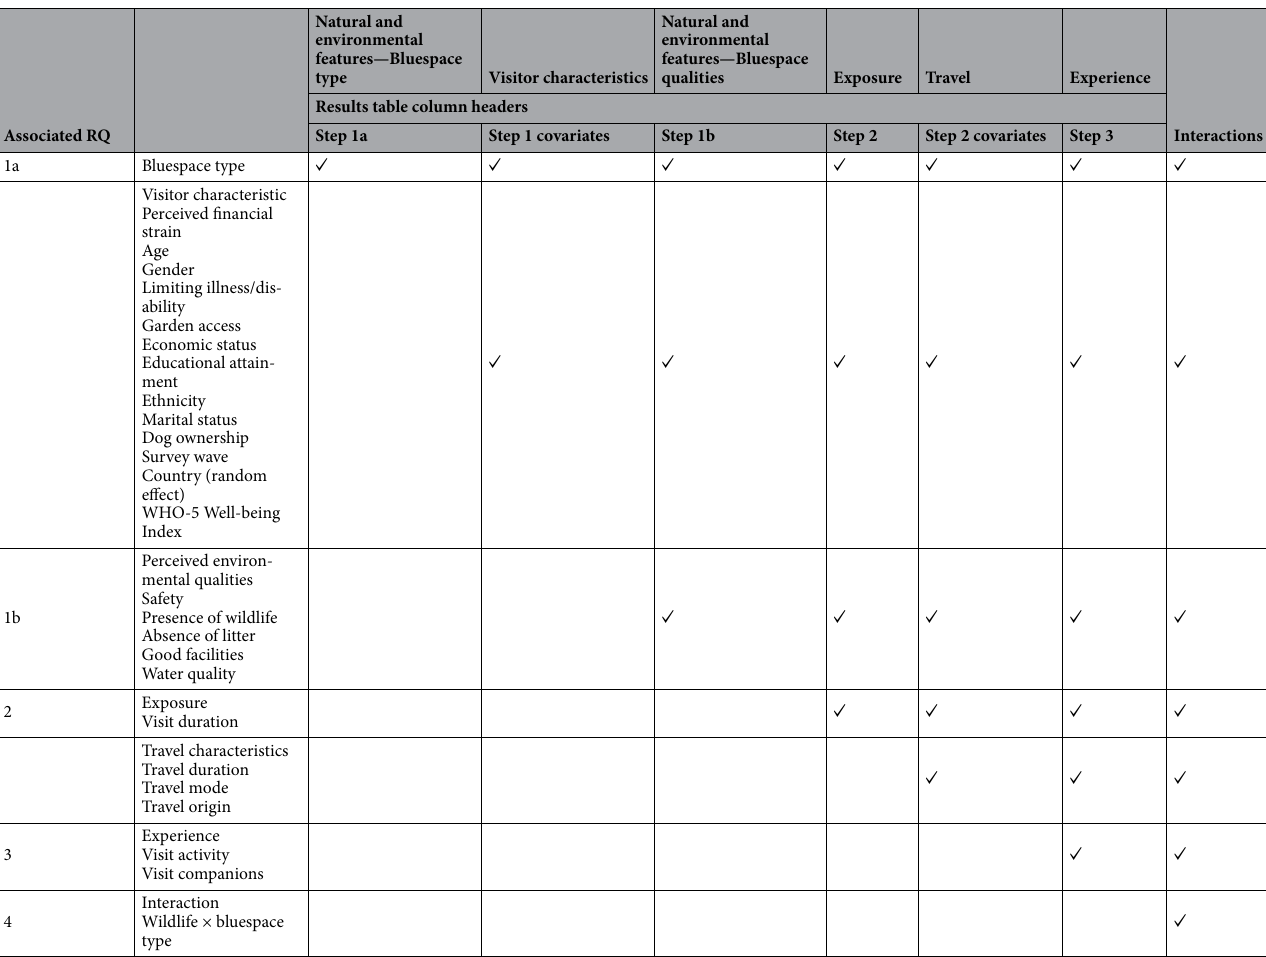
Table 2. Model variables. Variables included at each model